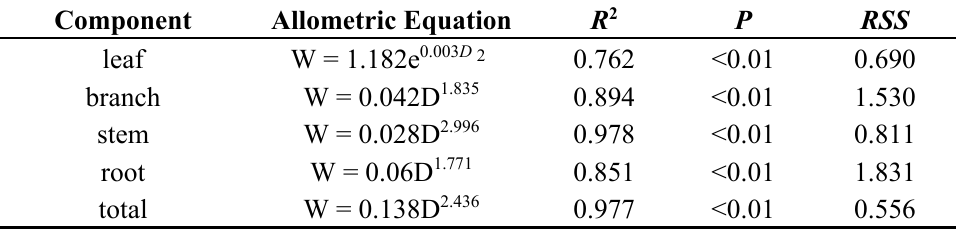
Table 2. Allometric regression models used to estimate biomass for Eucalyptus